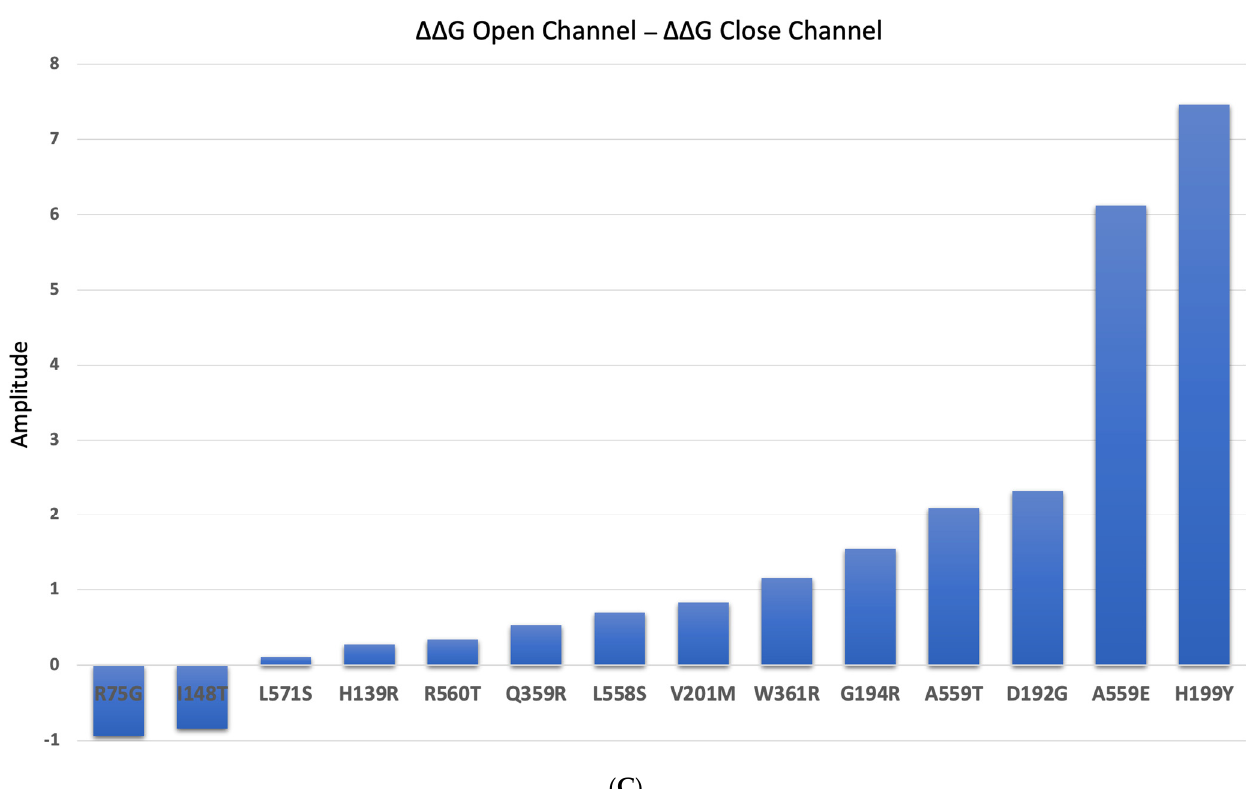
Figure 6. Energy prediction of ΔΔ G (kcal/mol) of CFTR mutants calculated with FoldX [29]. ( A )—using as template the phosphorylated ATP-bound human CFTR (PDB: 6msm)—“open” conformation [28]; ( B )—using as template the dephosphorylated ATP-free human CFTR (PDB: 5uak)—“closed” channel conformation [7]. The yellow bars correspond to the TMD1 variants, and the green bars correspond to the NBD1 variants. The limits for mutations to be classified as slightly stabilizing (ss), neutral (n), slightly destabilizing (sd), and destabilizing (d) are indicated as dotted gray lines. ( C )—Variation of ΔΔ G (kcal/mol) for CFTR variants calculated as the difference between the ΔΔ G “open” and the ΔΔ G “closed”. Positive values indicate mutations that are less destabilizing in the closed conformation. Mutations near 0 indicate that the destabilizing effects caused by mutations are almost similar in open or closed conformations. Mutations with negative values are less destabilizing in the open conformation.